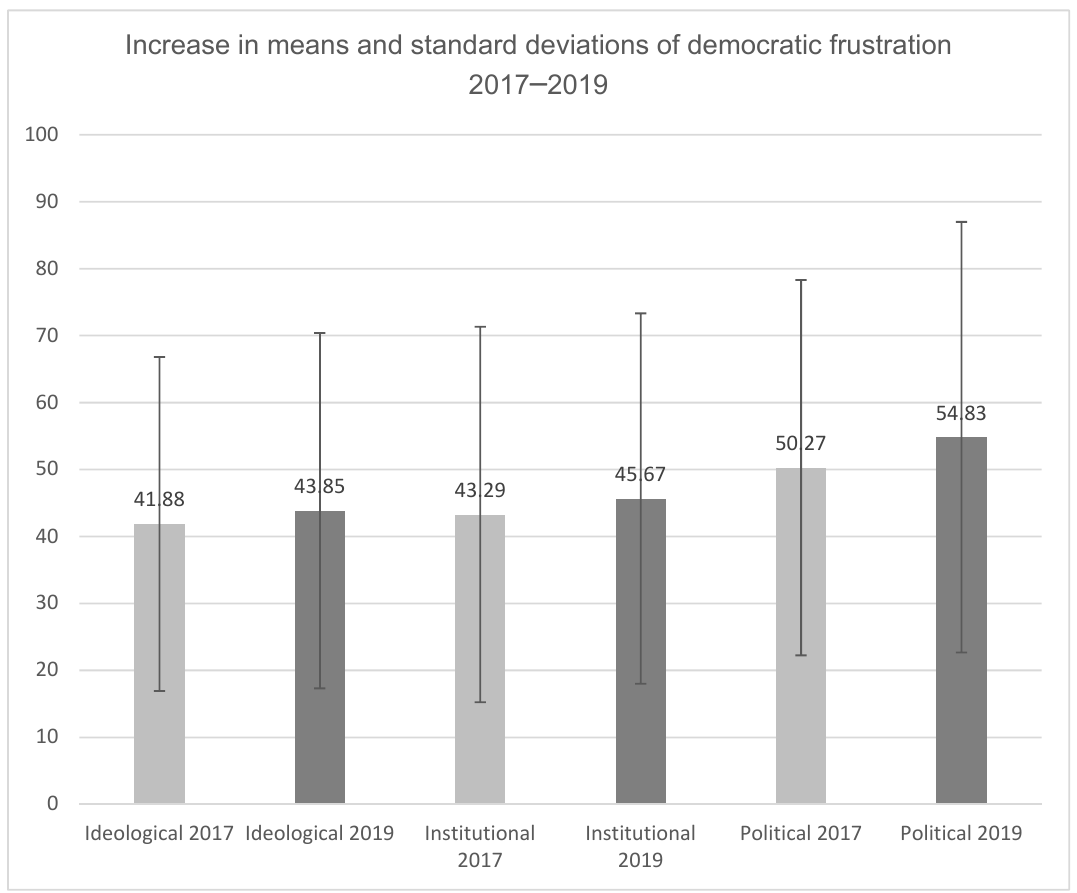
Figure 2. Evolution of three dimensions of democratic frustration: 2017–2019. Note: bars represent means. Lines represent standard deviations. Note: lines are NOT standard errors (confidence intervals) and significance of the differences in means are discussed in the main text.